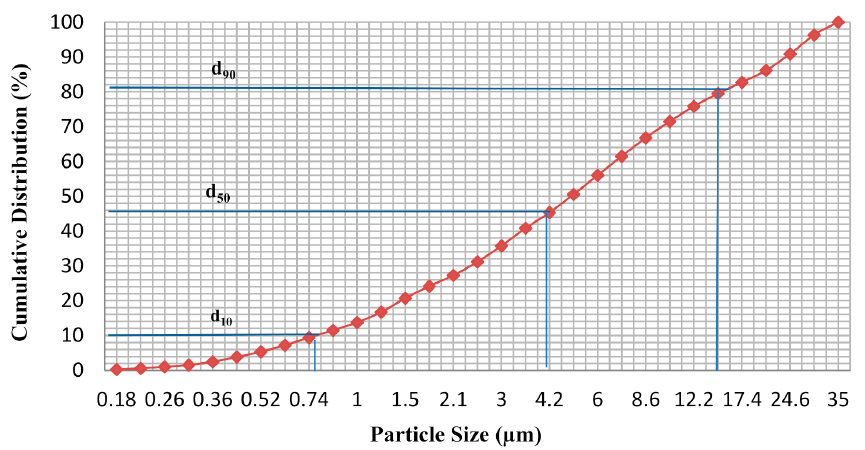
Figure 2. Particle size distribution of POFA.